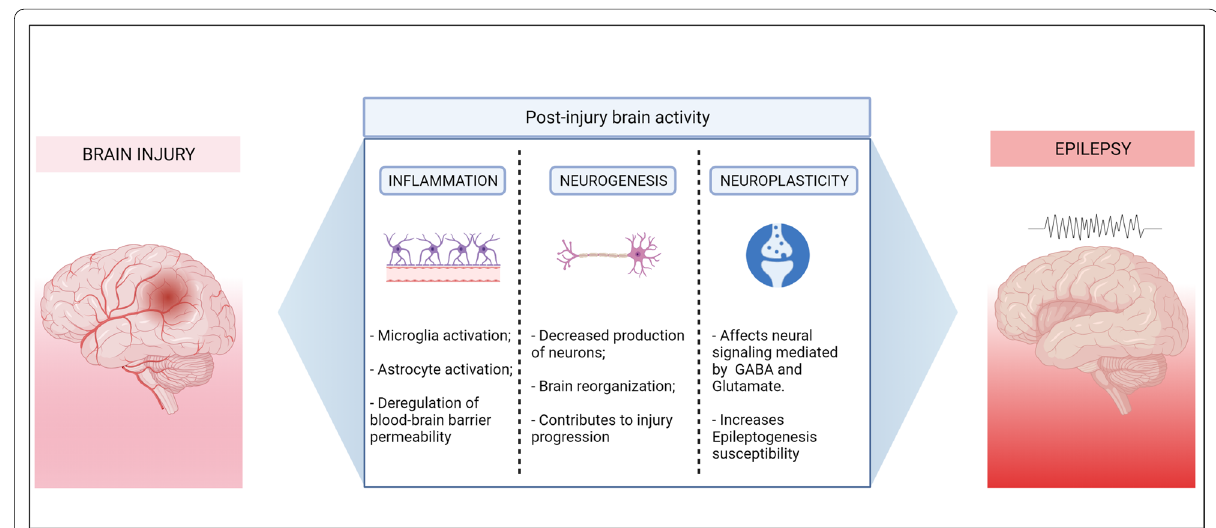
Fig. 1 Post‑injury brain